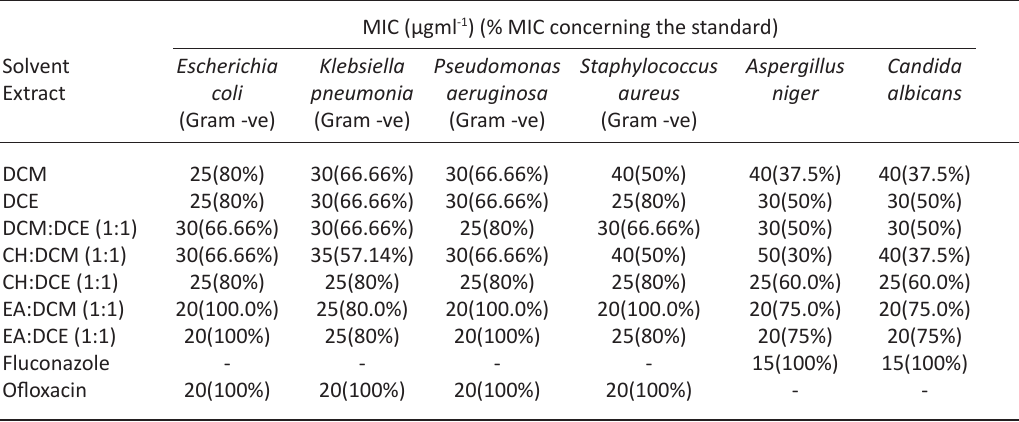
Table 3. Antimicrobial assessment data of the extracts of O. europaea leaves